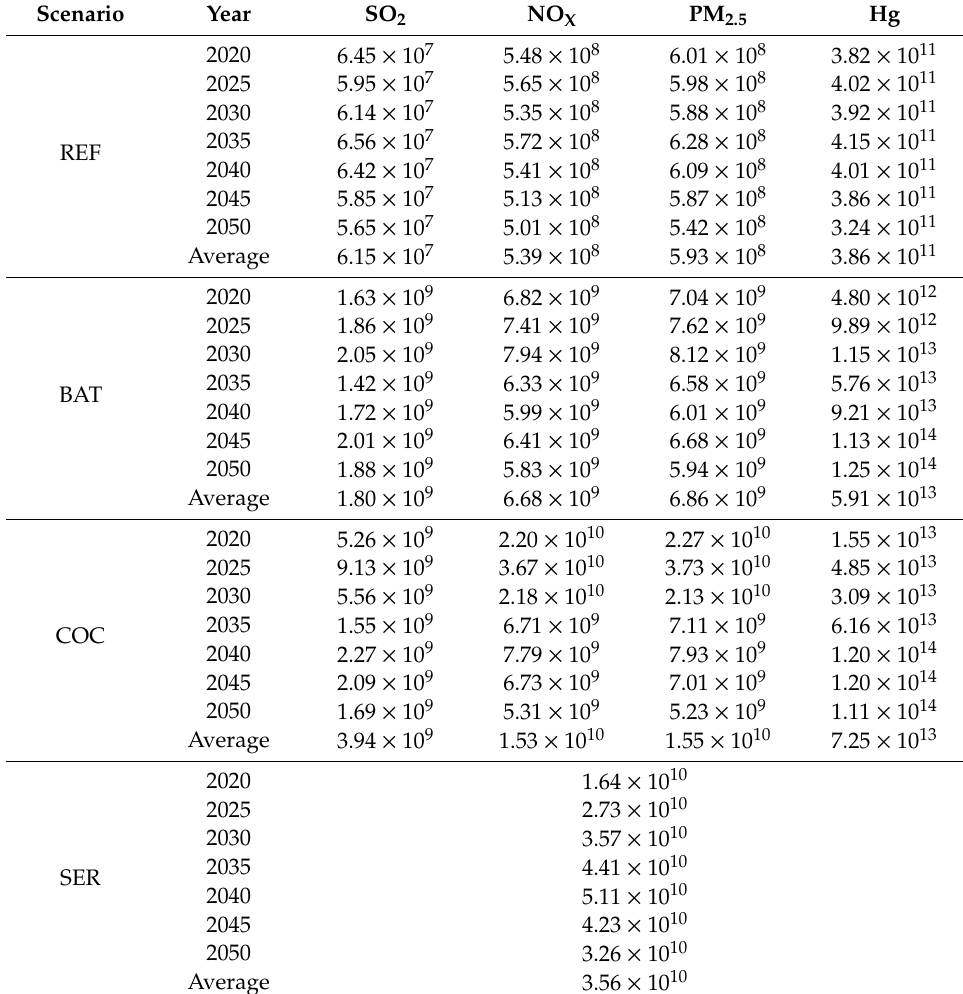
Table 7. Unit emission reduction cost of air pollutants (CNY / Mt).